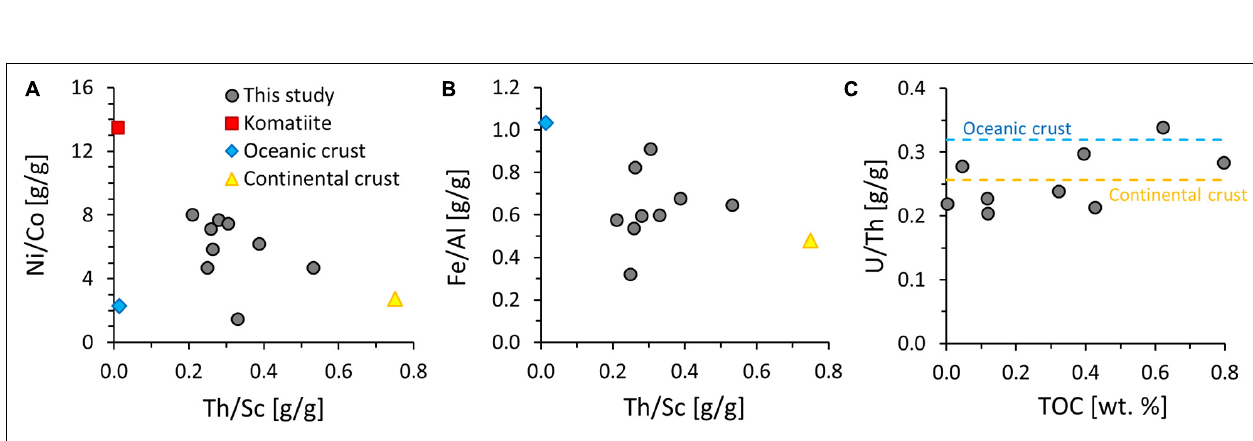
Frontiers in Earth Science |